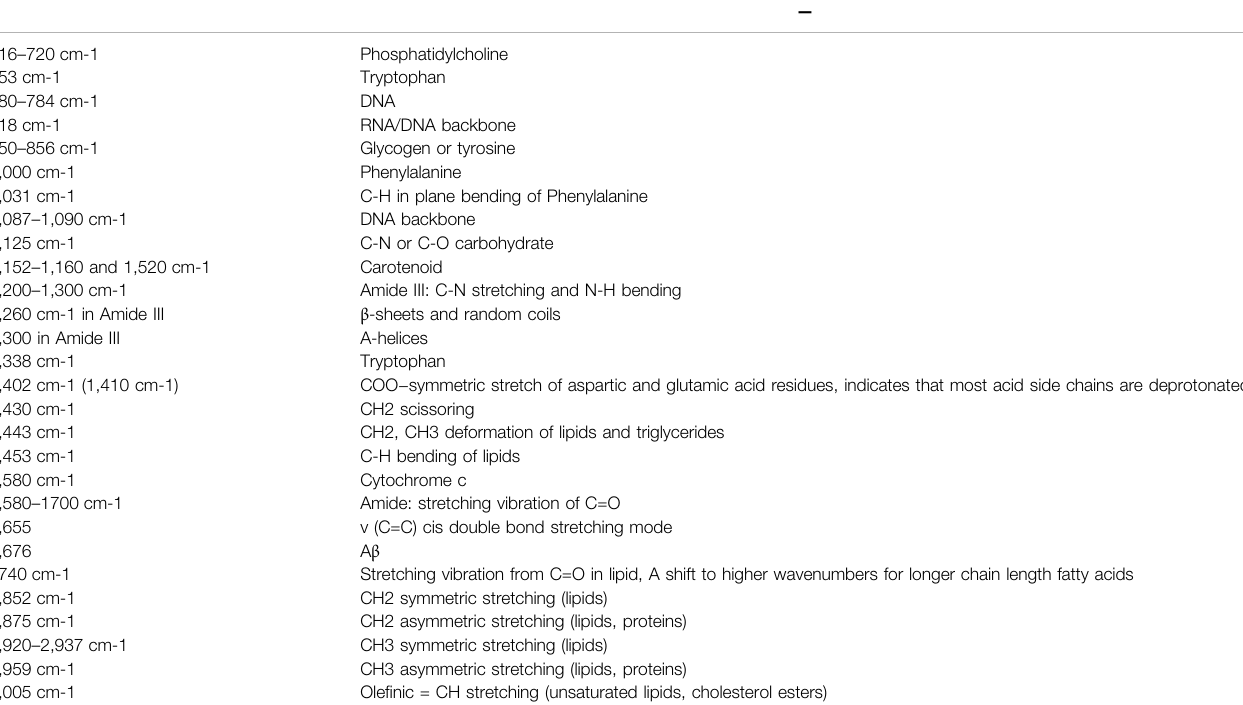
TABLE 1 | The chemical bond assignment of Raman peaks of Drosophila ovary.